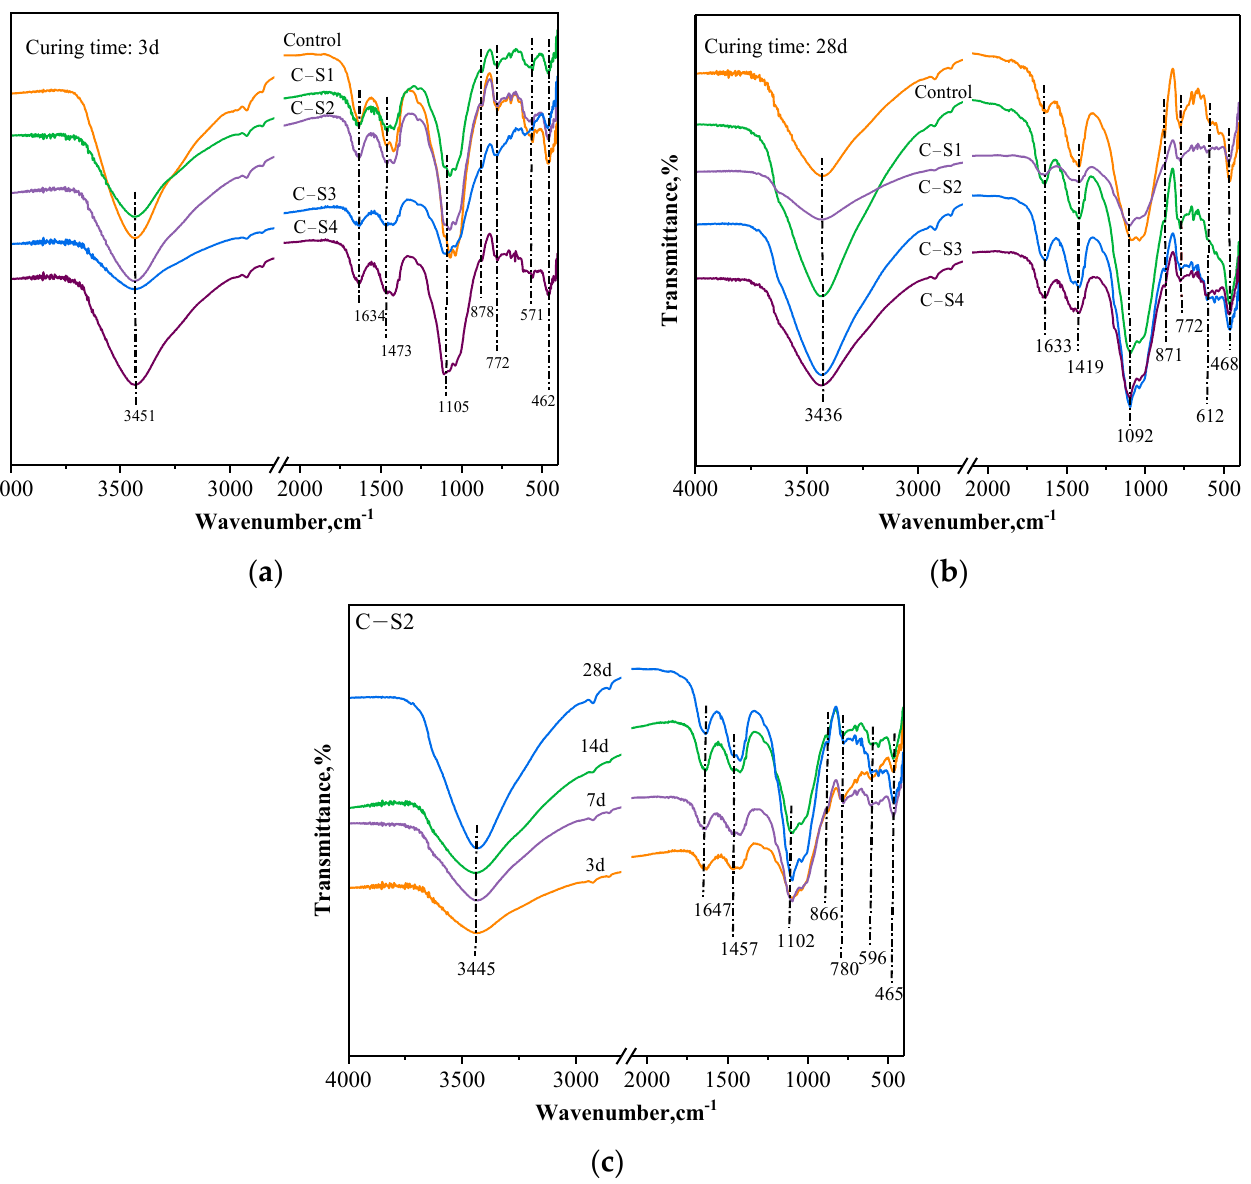
Figure 9. FTIR results of PCCPB samples. ( a ) 3 d; ( b ) 28 d; ( c ) C-S2.